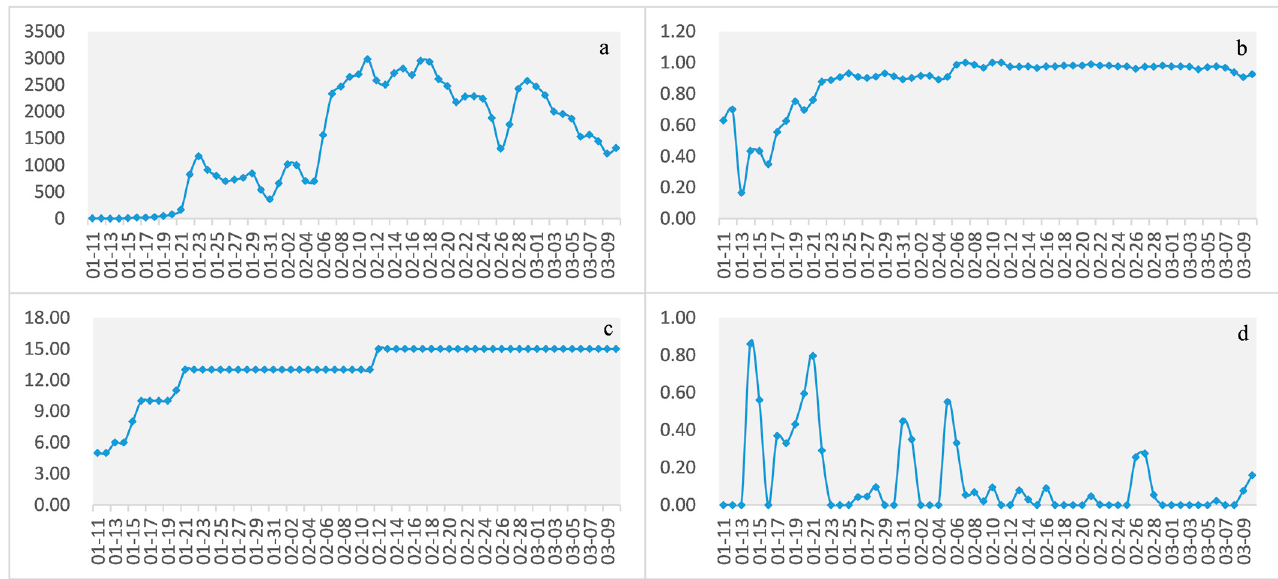
Figure 9. The metric values of semantic network: ( a ) average weighted degree; ( b ) average clustering coefficient; ( c ) network size; ( d ) average increment of semantic change